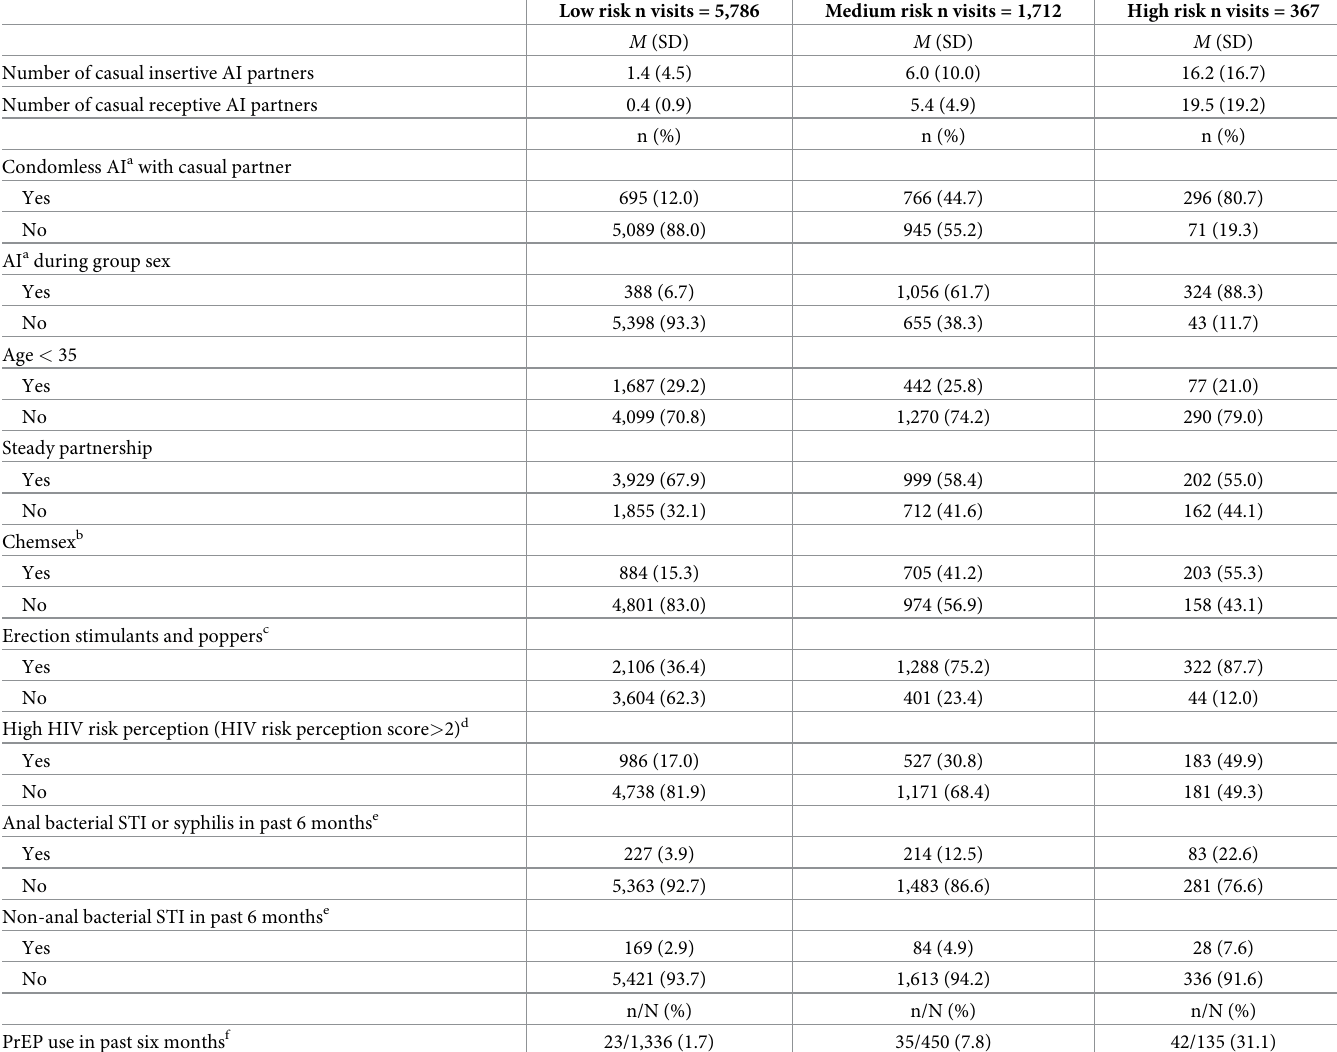
Table 1. Characteristics reported at visits classified as low, medium and high risk among MSM participating in the Amsterdam Cohort Studies, Amsterdam the Netherlands, between 2008 and 2017 (n =